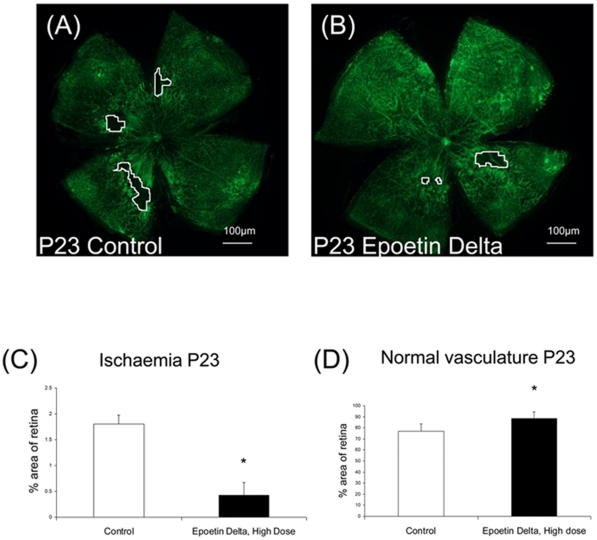
Epoetin delta enhances vascular recovery following OIR.Figs. 8 (A and B) illustrate the recovery of the vasculature in the retina and the ischaemic regions at P23 following OIR for formulation buffer treated mice and those which were treated with high dose of epoetin delta. Upon quantification the ischaemic area is decreased in epoetin delta treated mice relative to the formulation buffer treated animals (C) (*p<0.05) (n = 6). Inversely related to ischaemia, the area of normal vasculature is increased at P23 following epoetin delta treatment (D) (*p<0.05) (n = 6) (Error bars  =  Standard Error of the Mean).